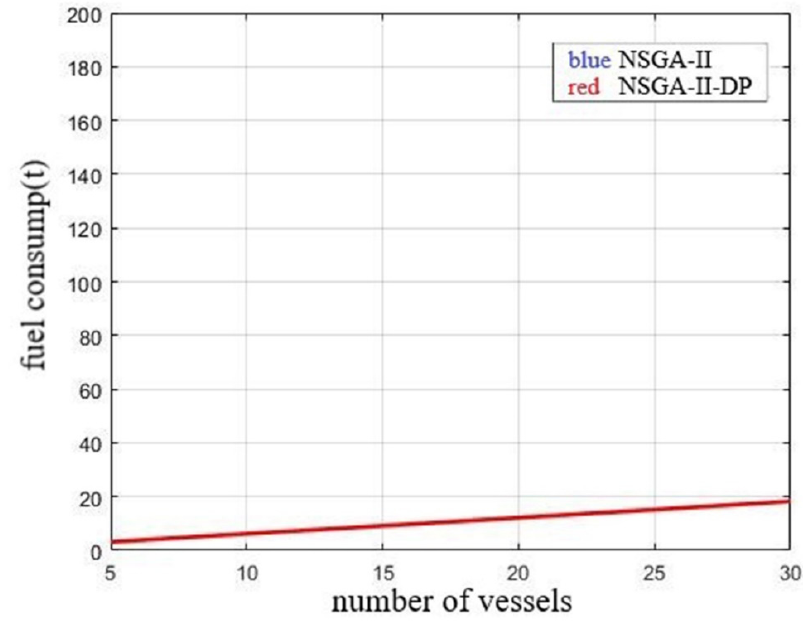
Figure 16. The average value of the optimal value of the fuel consumption over 10 calculations.